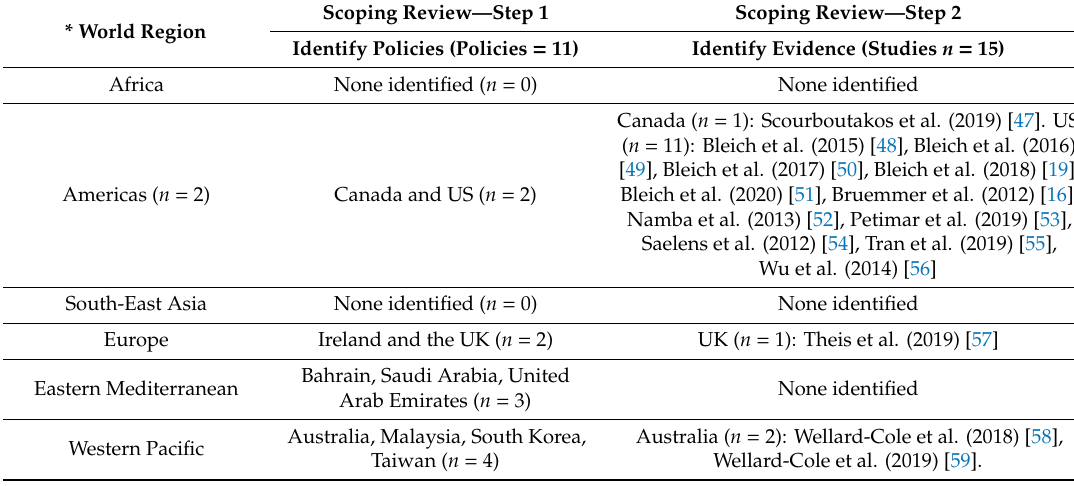
Table 2. Two-step scoping review results across countries by world